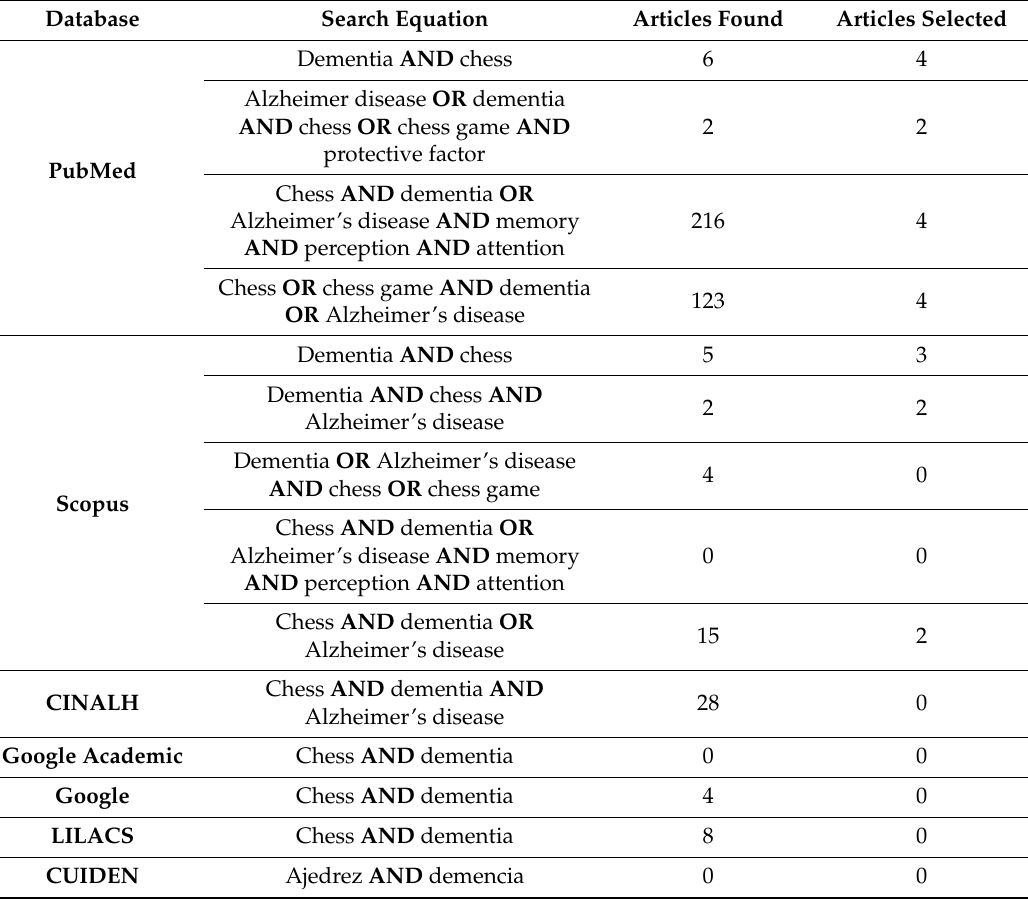
Table 1. Flowchart: search strategies in on-line